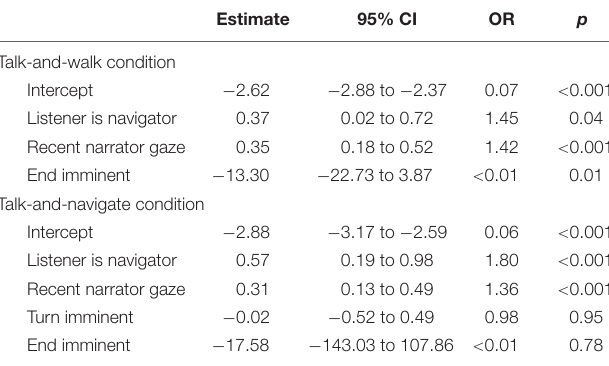
TABLE 1 | Mixed-effects logistic regression summaries for predictors testing the listener response hypothesis for verbal behavior (recent narrator gaze as predictor for verbal listener response) in two